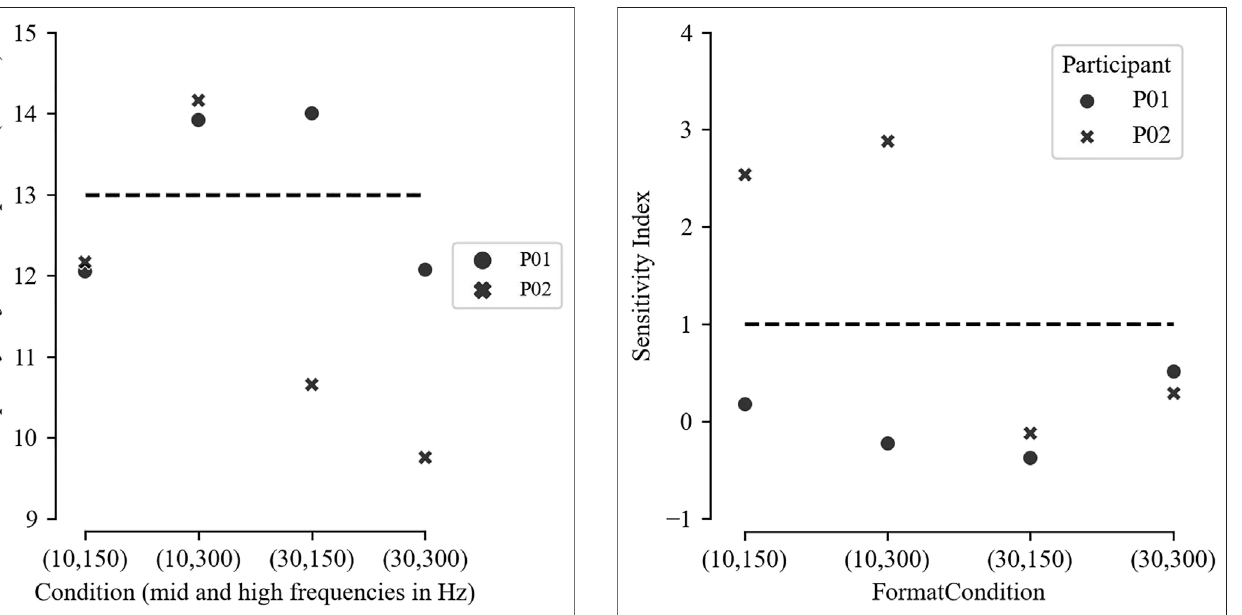
FIGURE 6 | Adjusted amplitudes of mid frequencies in dB SL from intensity matching in Exp. 2. The horizontal dashed line denotes 13 dB SL.